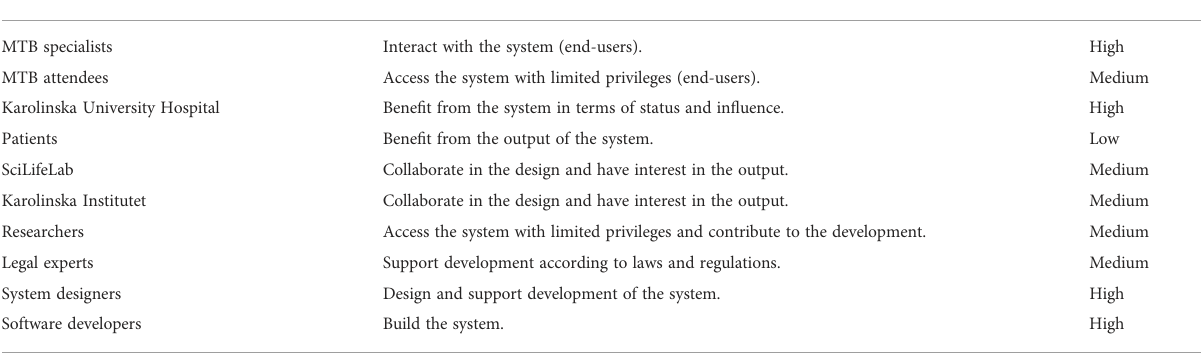
TABLE 2 Stakeholder analysis of the project based on the Volere Stakeholder Analysis Template